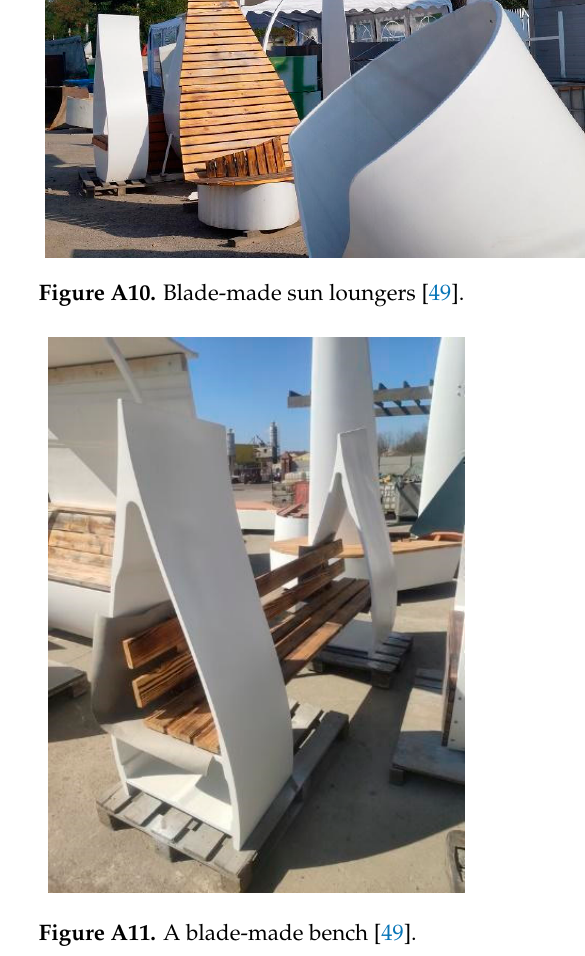
Figure A11. A blade-made bench [49].